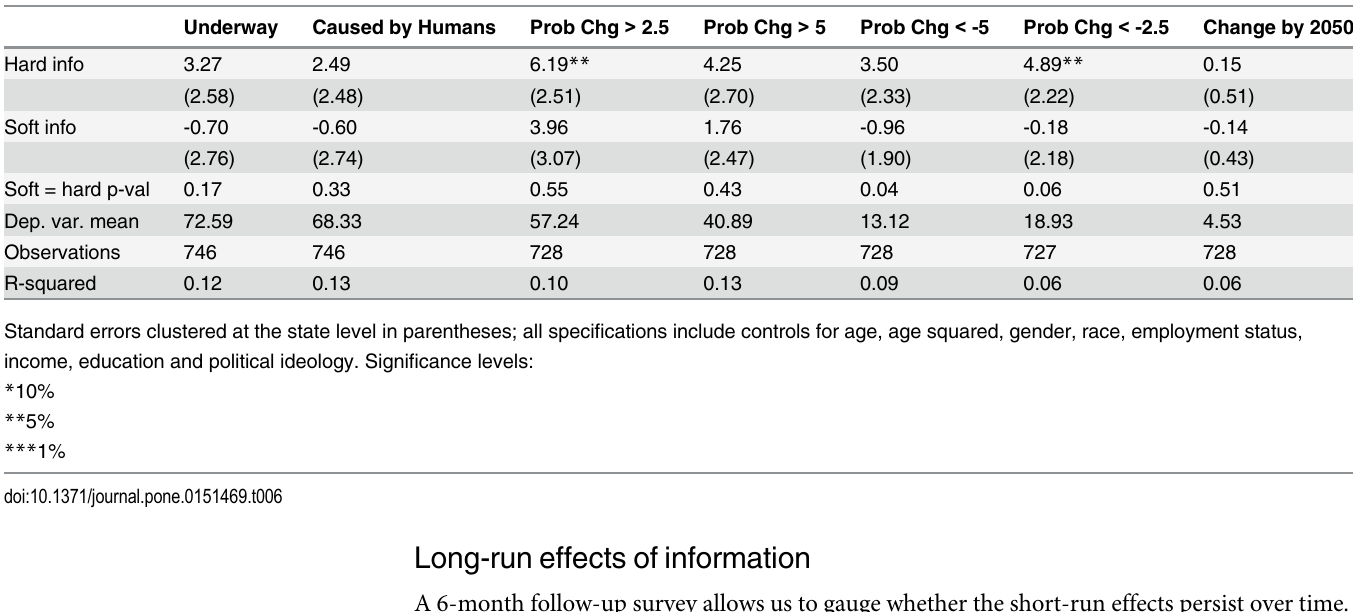
Table 6. Average long-run effects of information on beliefs about climate change.